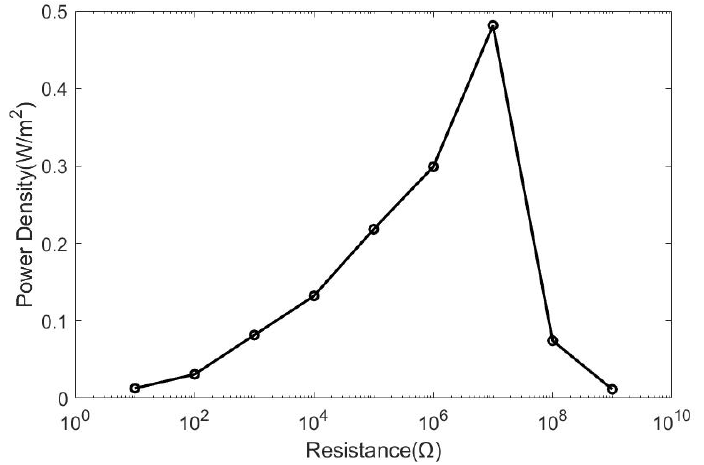
Figure 7. Power density of the HDR-TENG on the varying loading resistance. The specification of the HDR-TENG: h is 1.3 mm, the rotation speed is 12,800 rpm with a 25 cm wire length, and the load resistance is 10 M Ω .